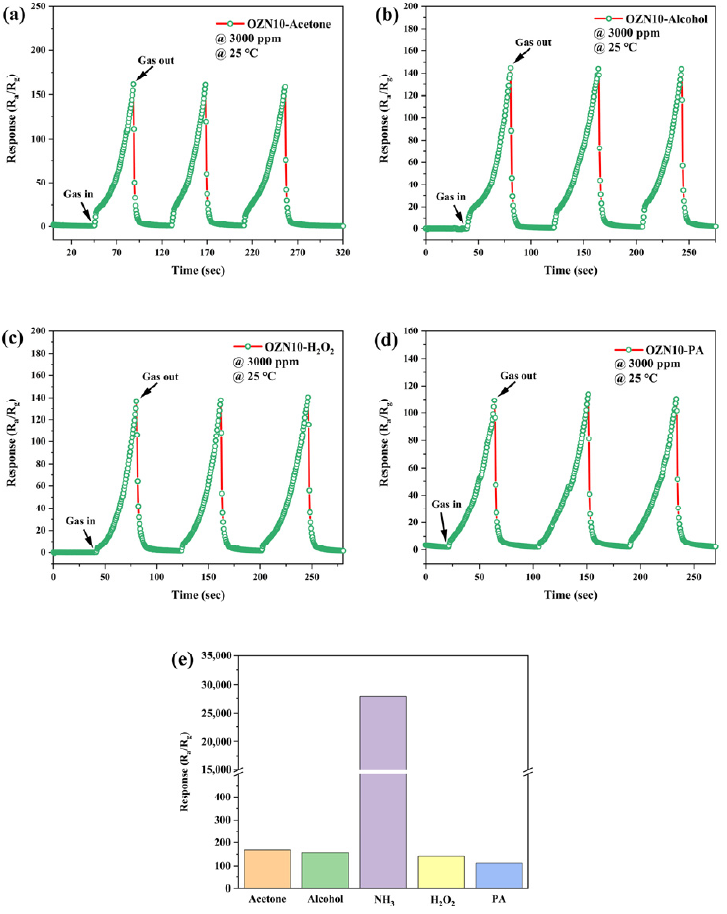
Figure 16. ( e ) Dynamic response diagram and histogram of OZN-10 to saturated ( a ) acetone, ( b ) alcohol, ( c ) H 2 O 2 and ( d ) PA (3000 ppm, 25 °C).